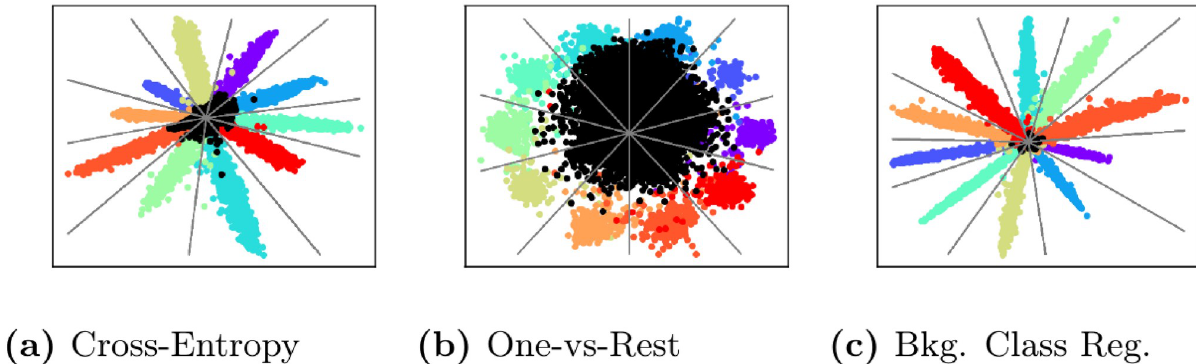
Fig 2. Feature space regularization. 2-D visualization of the effect of the different feature space regularization strategies on separating in-distribution and outlier inputs The in-distribution training set is MNIST while the open set classes are drawn from the Fashion-MNIST dataset [53]. For background class regularization, the EMNIST-Letters dataset [54] is used as a source for background samples.